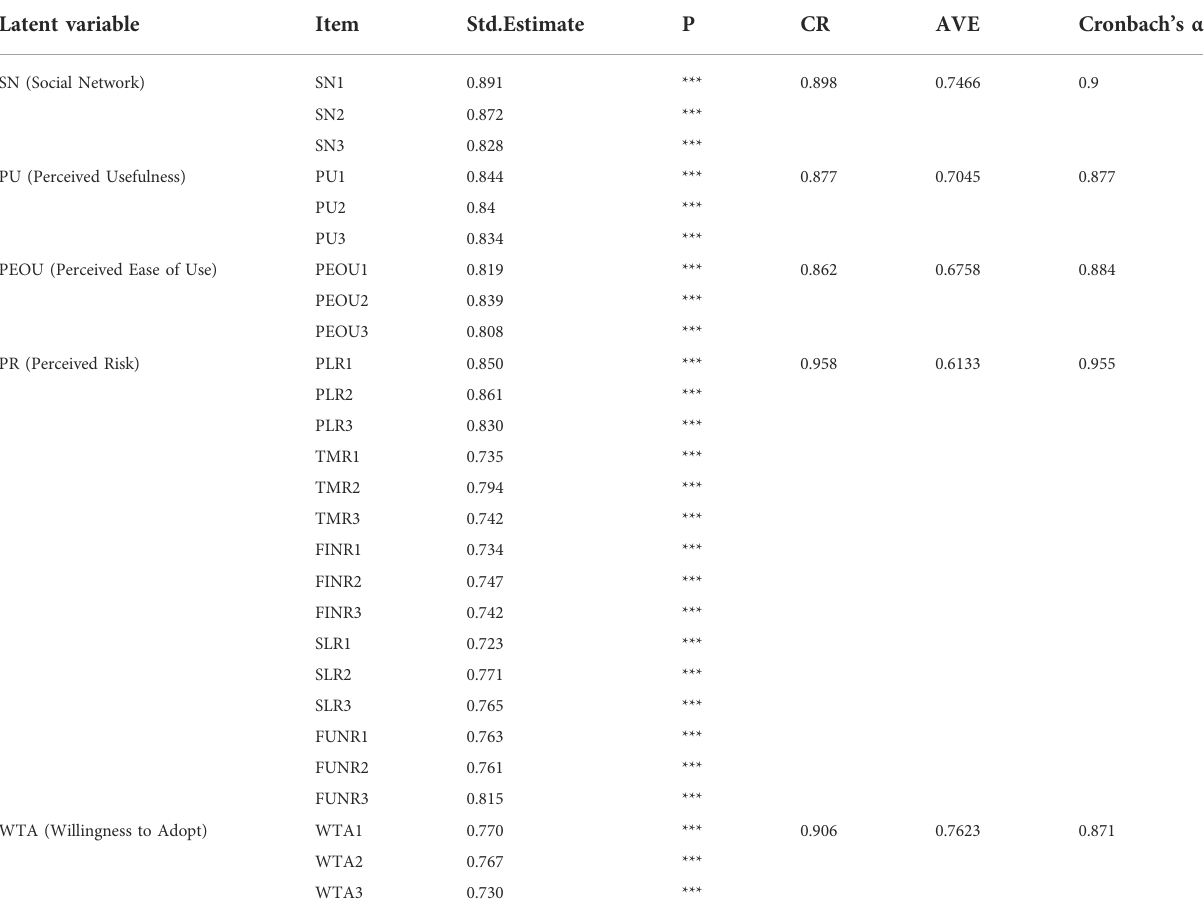
TABLE 2 Results of reliability and validity analysis.